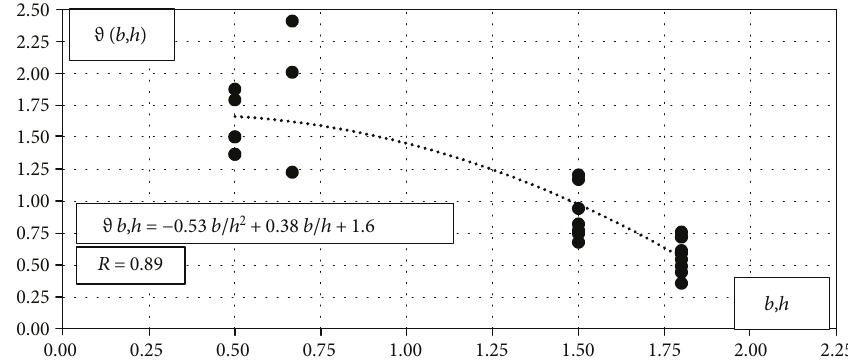
Figure 11: The function of cross-sectional parameters ϑ b , h .